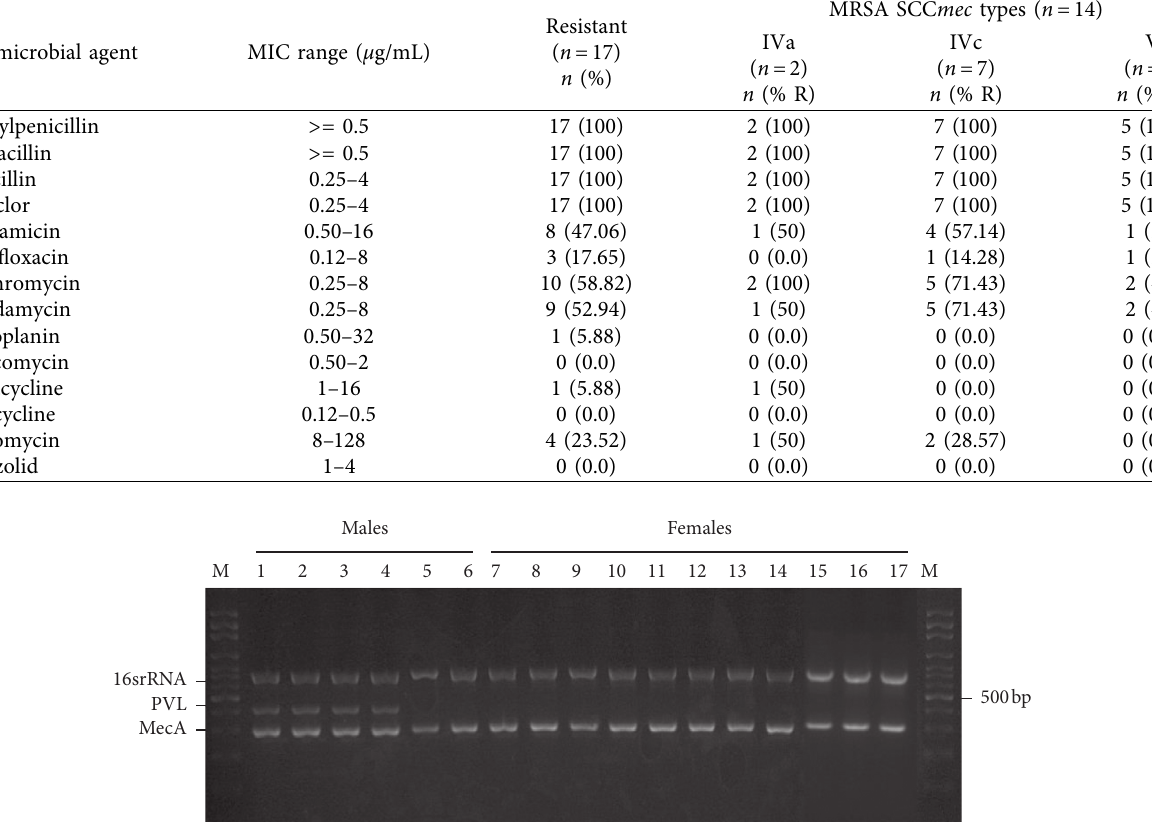
Table 1: Antibiotic resistant profile of MRSA isolates from elderly residents and nurses. Antimicrobial agent